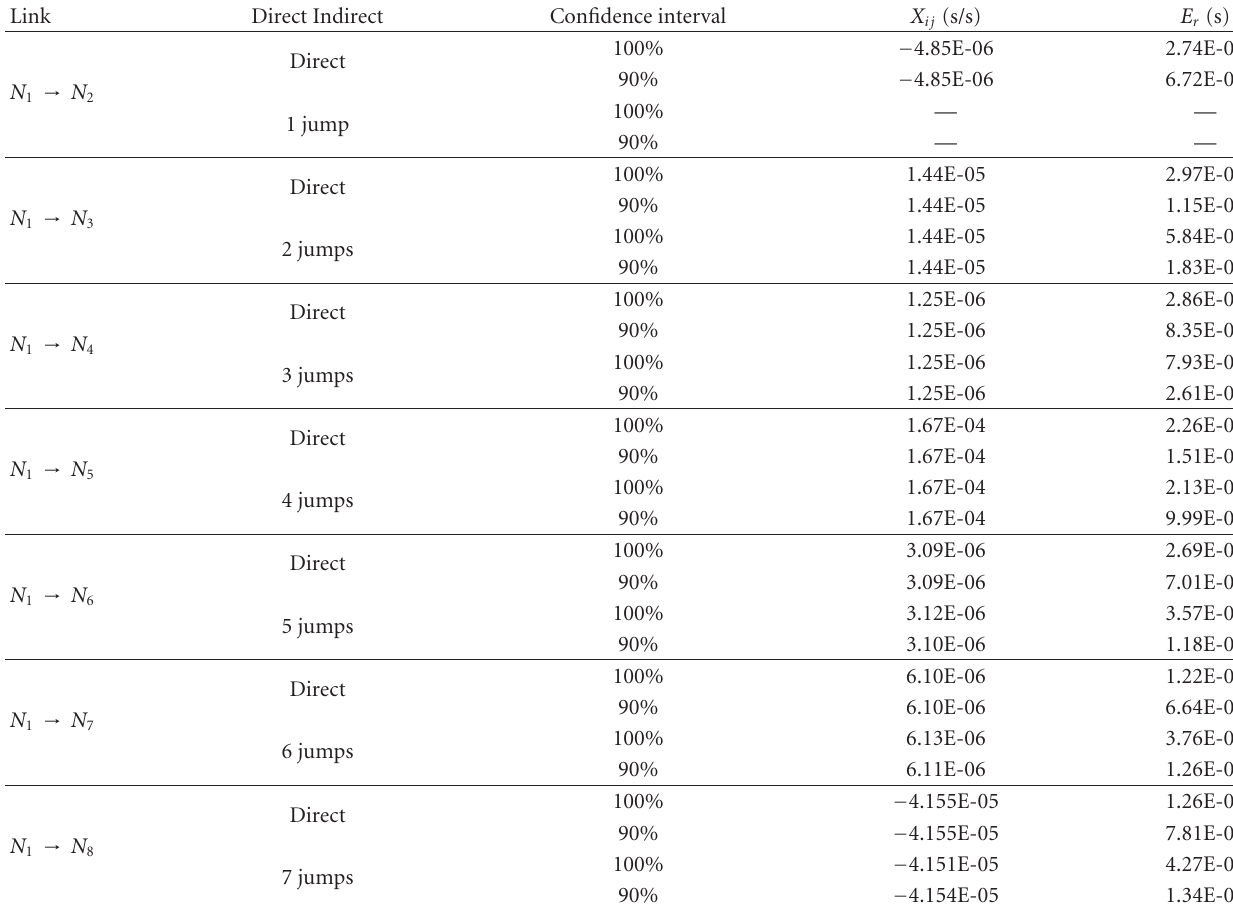
Table 7: Comparison of the clock drift approximation between direct and indirect